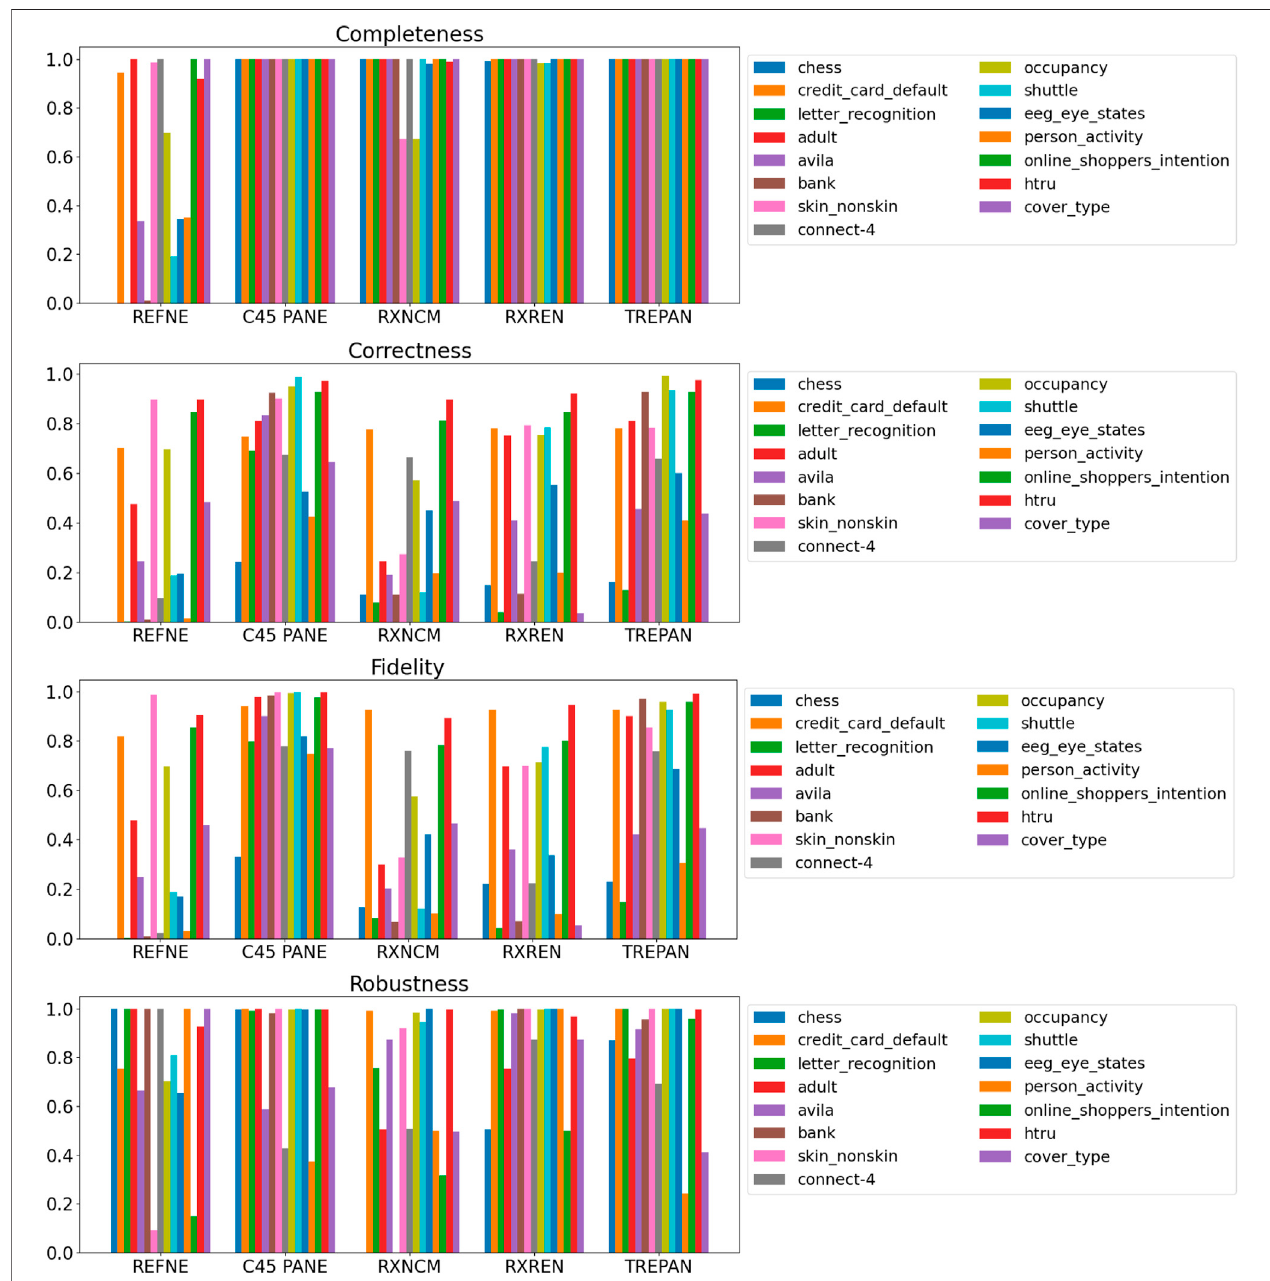
FIGURE6| Quantitativemeasuresofthedegreeofexplainabilityoftherulesetsautomaticallygeneratedby5rule-extractionmethodsover15datasets,groupedby method.